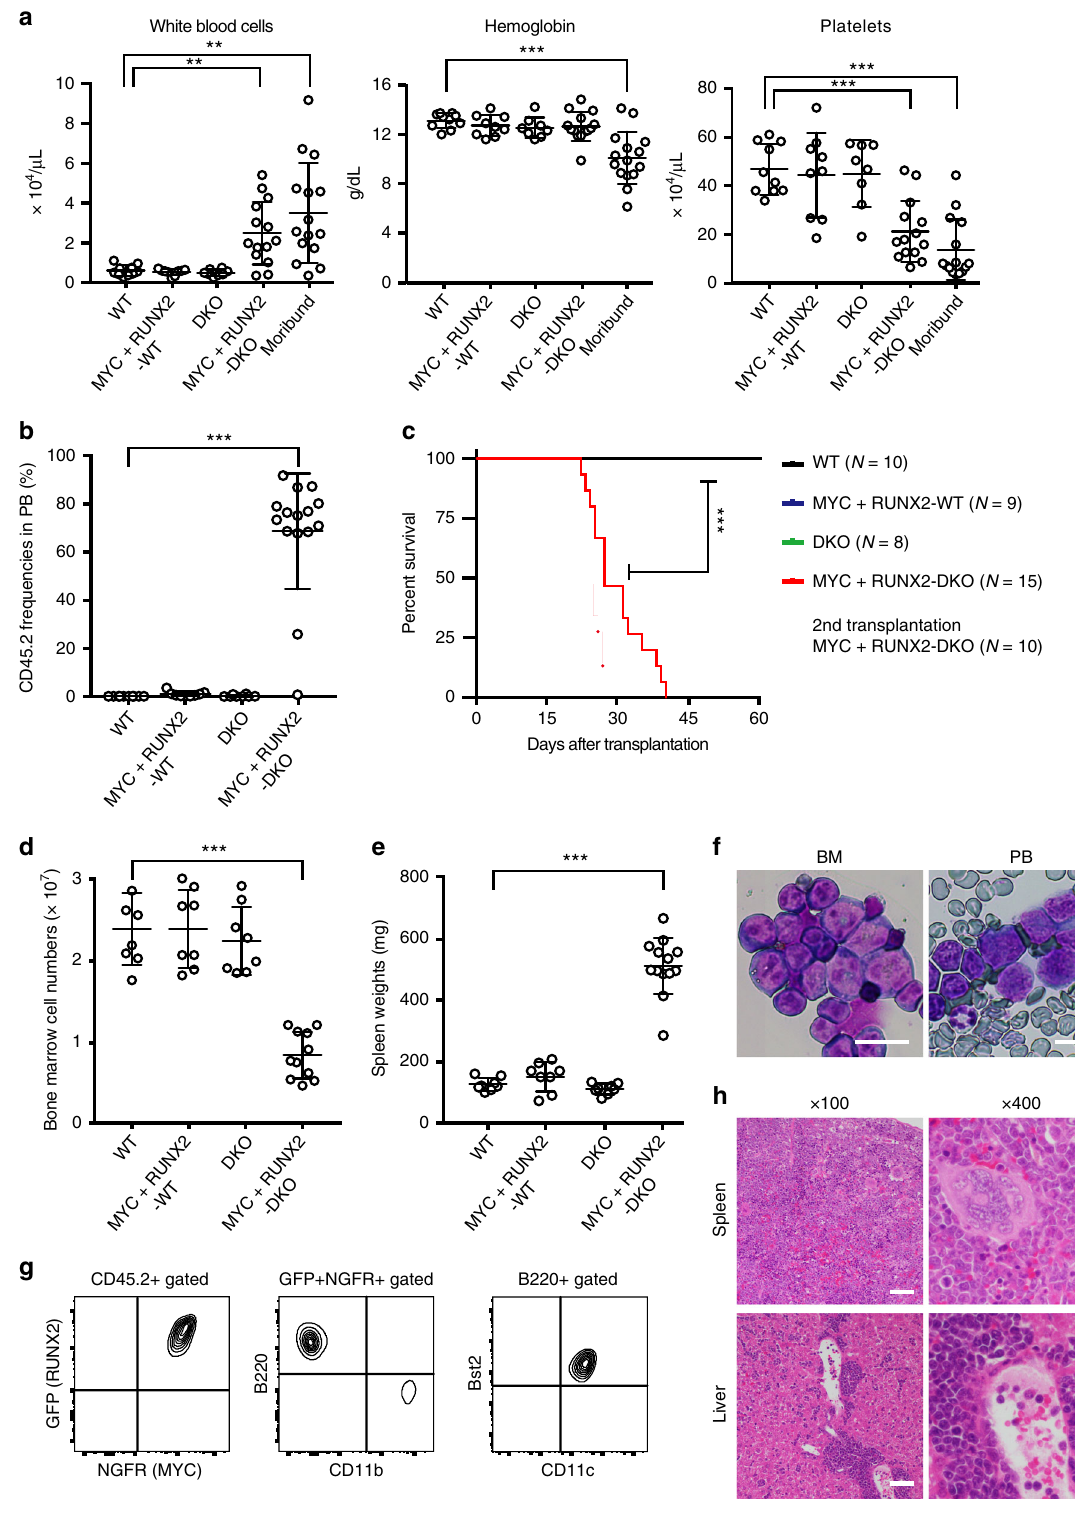
While WT, MYC + RUNX2-WT, and DKO mice did not show mice died 1 month post-transplantation (Fig. 7c), whereas there signi fi cant changes in blood counts in peripheral blood (PB) were no lethal hematological malignancies in MYC + RUNX2-WT (Fig. 7a) due to the negligible populating capacities of CD45.2 + or DKO mice 6 months post-transplantation. At the time of killing, MYC + RUNX2-DKO moribund mice had signi fi cantly cells 3 weeks post-transplantation (Fig. 7b), MYC + RUNX2-DKO lower bone marrow cell counts and larger spleens than the other moribund mice showed robust leukocytosis, anemia, and genotype mice (Fig. 7d, e). A detailed analysis of moribund mice thrombocytopenia (Fig. 7a) following the emergence and revealed the expansion of immature leukemic blasts with a high expansion of CD45.2 + cells (Fig. 7b). All MYC + RUNX2-DKO NATURE COMMUNICATIONS| (2019) 10:1653